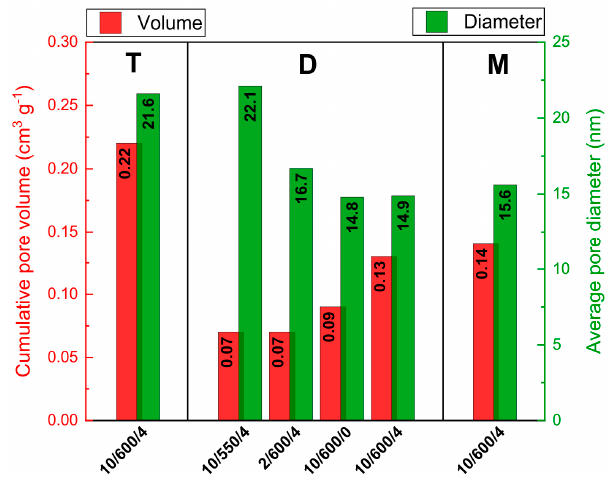
Figure 3. Cumulative pore volume and average pore diameter for carbon nitrides obtained from different precursors under different thermal synthesis conditions.